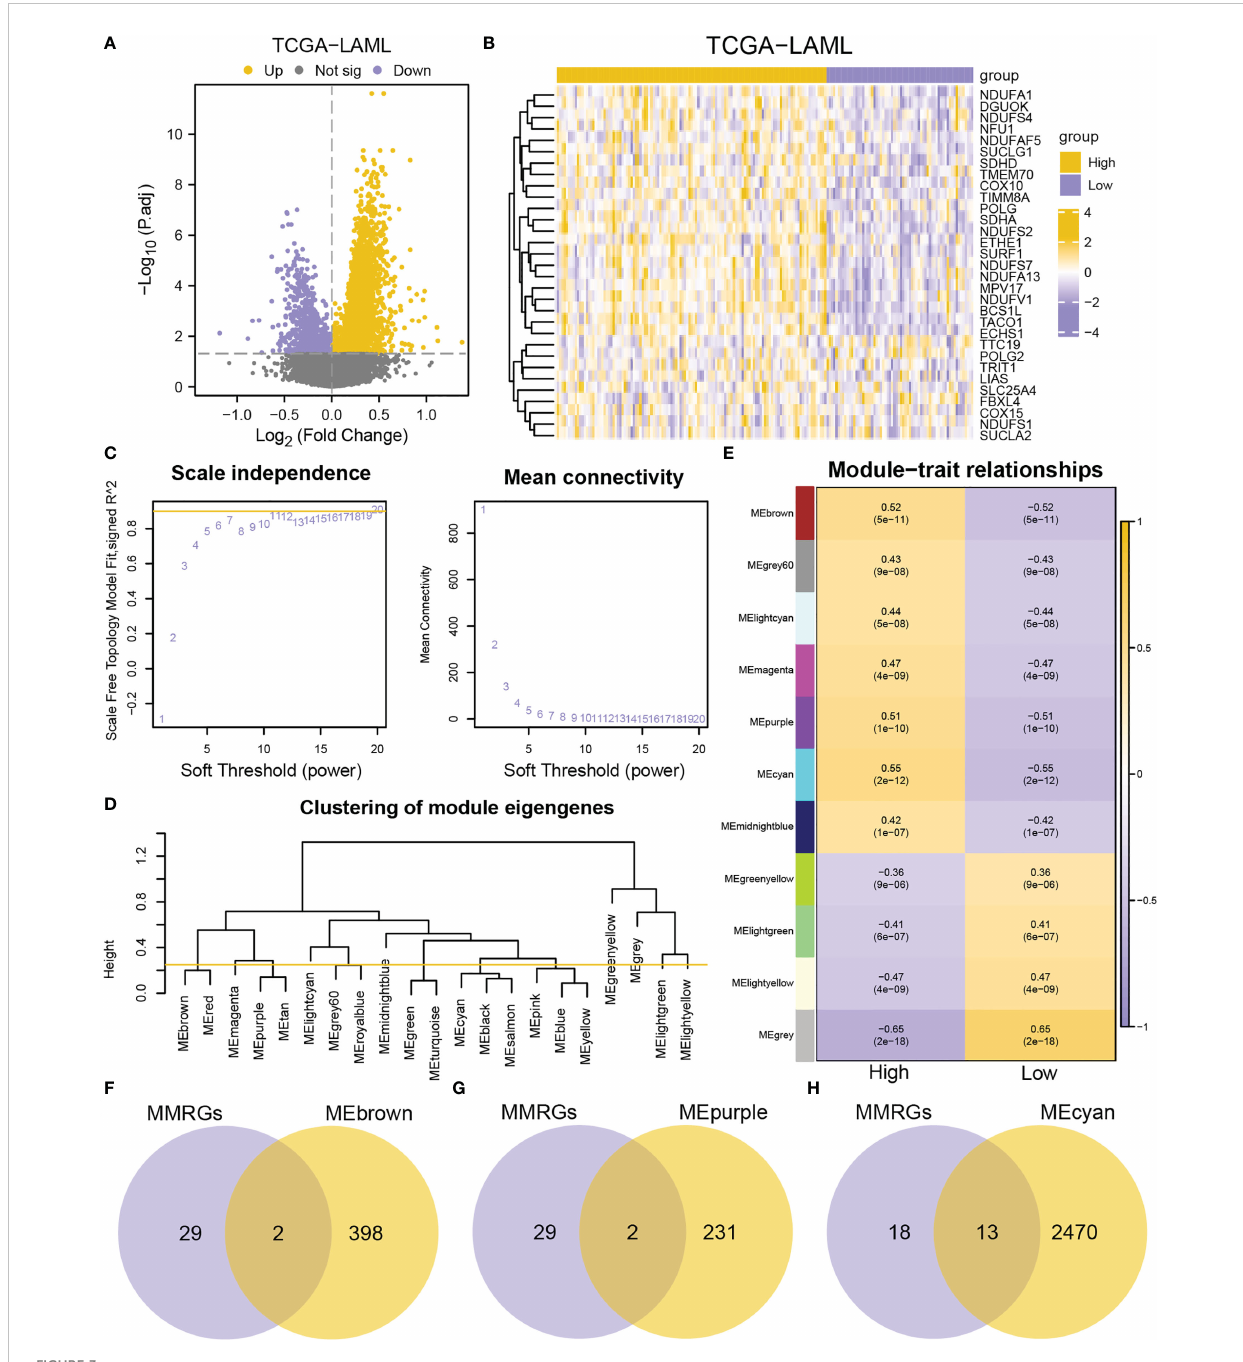
FIGURE 3 Identi fi cation of co-expression modules by WGCNA. (A) Volcano plot of DEGs between high- and low-MMs groups in the TCGA-LAML dataset. (B) Heatmap of MMRGs in the TCGA-LAML dataset. (C) The mean connectivity and scale free topology module fi t for different soft-threshold powers. (D) A cluster dendrogram of module eigengenes. (E) Relationships between the module eigengenes and MMs. (F-H) Venn diagrams of MMRGs with MEbrown (F) , MEpurple (G) , and MEcyan (H)